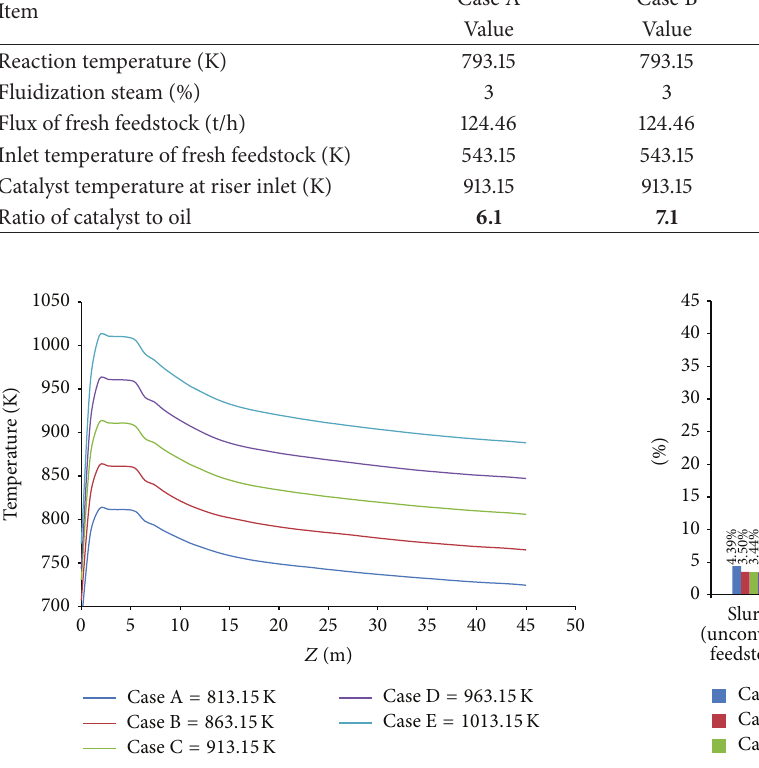
Figure 13: Temperature profiles through riser altering catalyst tem- perature profiles for the riser with variations in catalyst temperature.